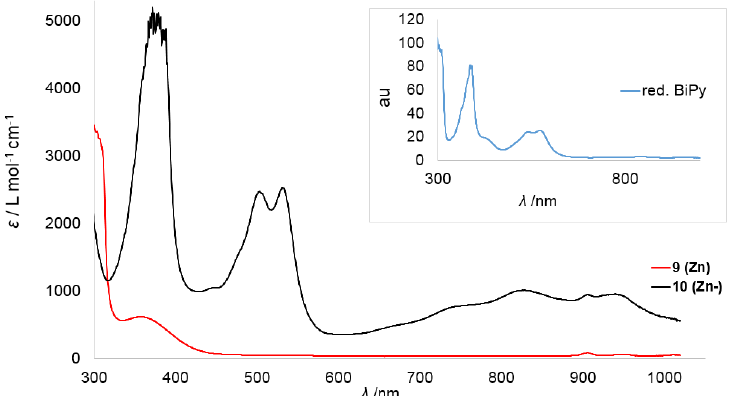
Figure 5. Overlay of the UV / Vis spectra of the Zn complexes 9 (Zn) and 10 (Zn − ) in Et 2 O. The inset belongs to the in situ spectrum of 2, 2′ -bipyridine reduced by KC 8 in the presence of 18-crown-6 in Et 2 O after approximately 3 min.